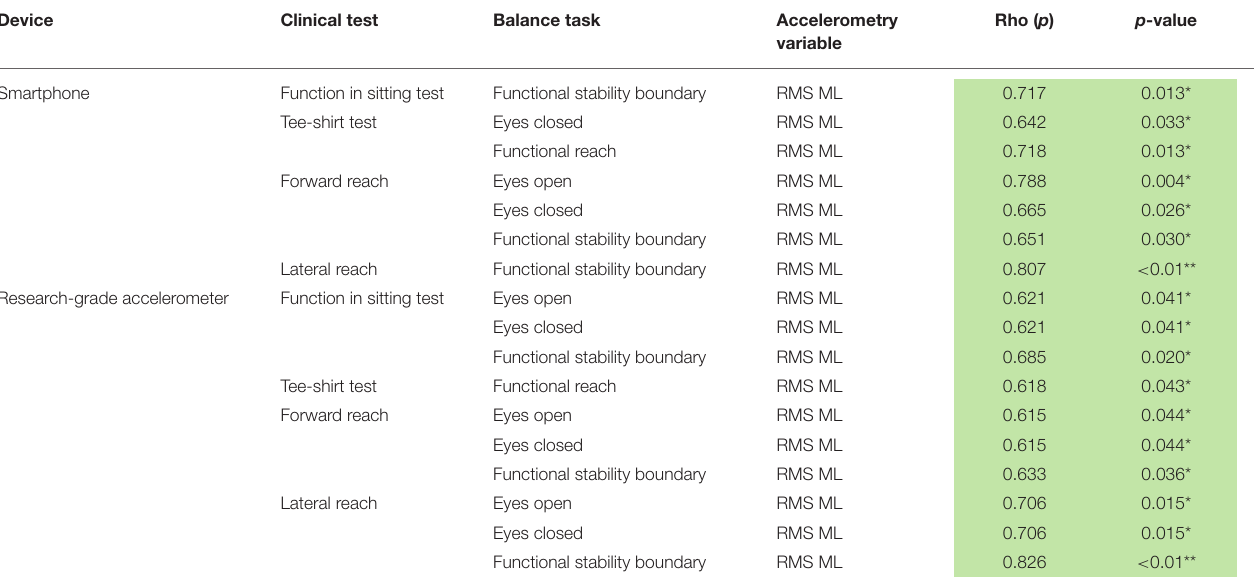
TABLE 2 | Presents the correlations (Rho) between clinical test outcomes and root mean square (RMS) acceleration as derived through smartphone and research-grade accelerometry.